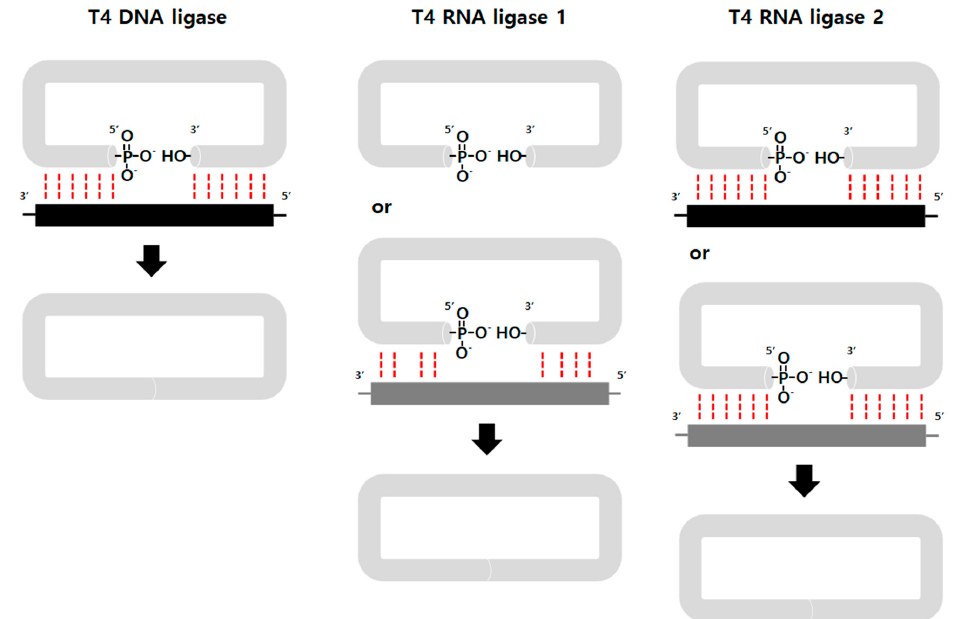
Figure 3. Enzyme-based methods. T4 DNA ligase requires ATP as a cofactor and catalyzes the formation of a phosphodiester bond between a 5 (cid:48) -phosphate and a 3 (cid:48) -hydroxyl group, only in cases of perfect complementarity (red dotted line) between the two strands (RNA in gray, DNA splint in black) at the ligation junction [32]. T4 RNA ligase 1 accepts DNA and RNA fragments as substrates and works on single-stranded substrates with lower reaction specificity [33]. RNA splint (dark gray) or intrinsic secondary structure leaving 2~3 nucleotides unpaired increases efficiency [26,34]. T4 RNA ligase 2 ligates the RNA acceptor strand (3 (cid:48) -OH) with RNA or the DNA donor strand (5 (cid:48) -phosphate) [35]. An RNA or DNA splint can be used to bring the 5 (cid:48) and 3 (cid:48) ends